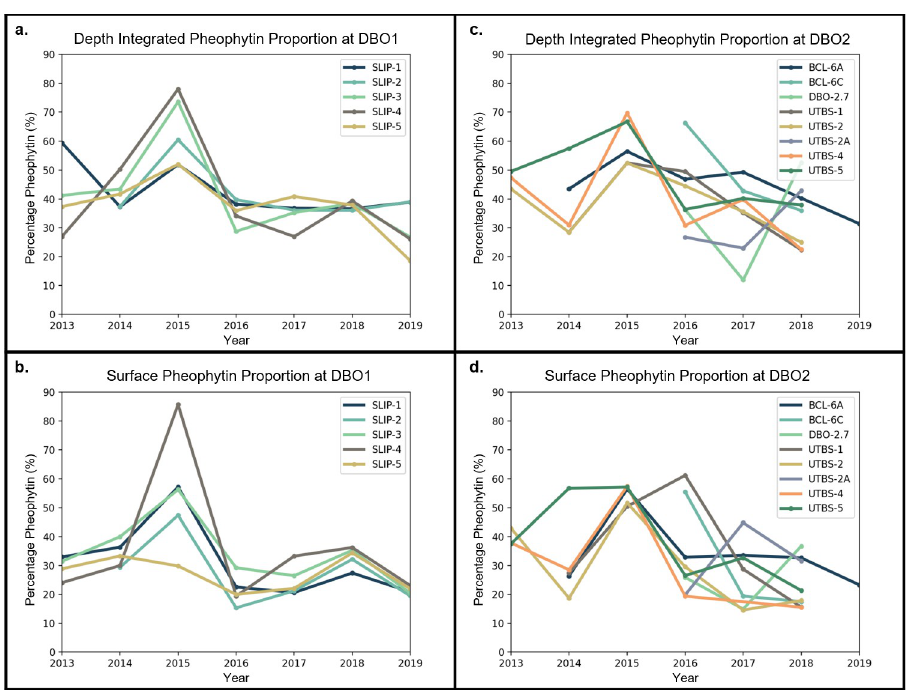
Fig 8. Pheophytin proportion time series. Depth integrated (a, c) and surface (b, d) pheophytin proportions at each station in DBO1 (a, b) and DBO2 (c, d) over time.